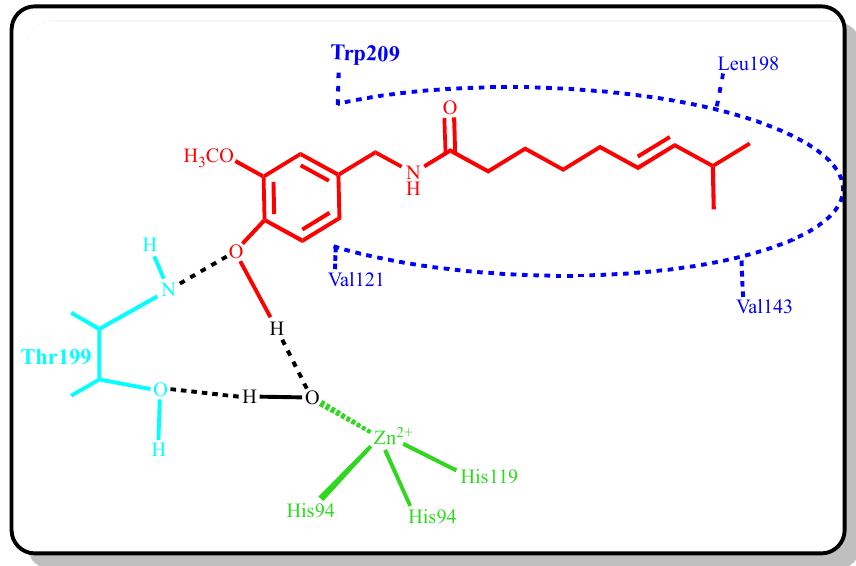
Figure 1. The proposed binding model of capsaicin to CA by anchoring to the Zn 2+ coordinated water/hydroxide ion